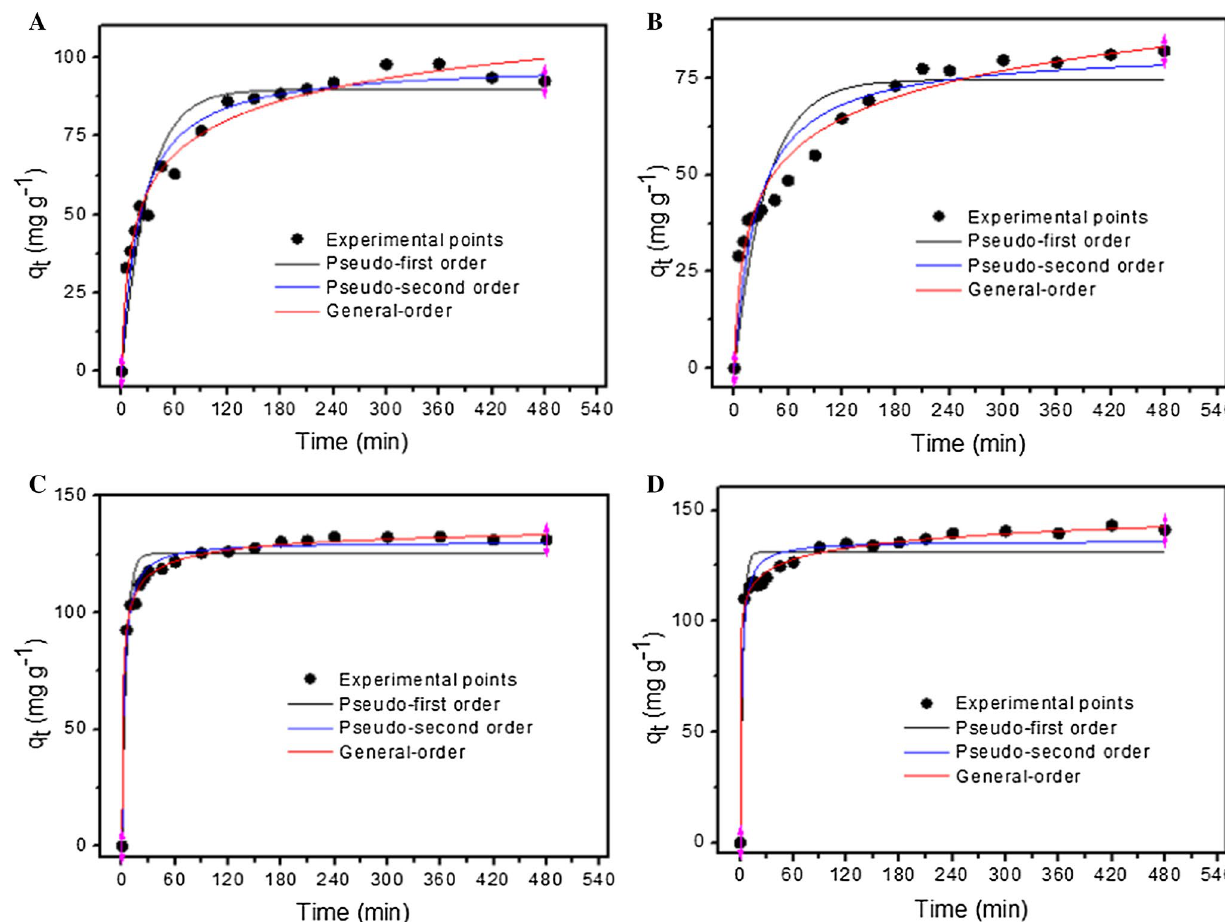
Fig. 4 Kinetic isotherm curves of a CAC and PR-5B dye at 400 mg L −1 ; b CAC and PR-5B dye at 600 mg L −1 ; c APC-1.0 and PR-5B at 400 mg L −1 ; and d APC-1.0 and PR-5B at 600 mg L −1 . Conditions: